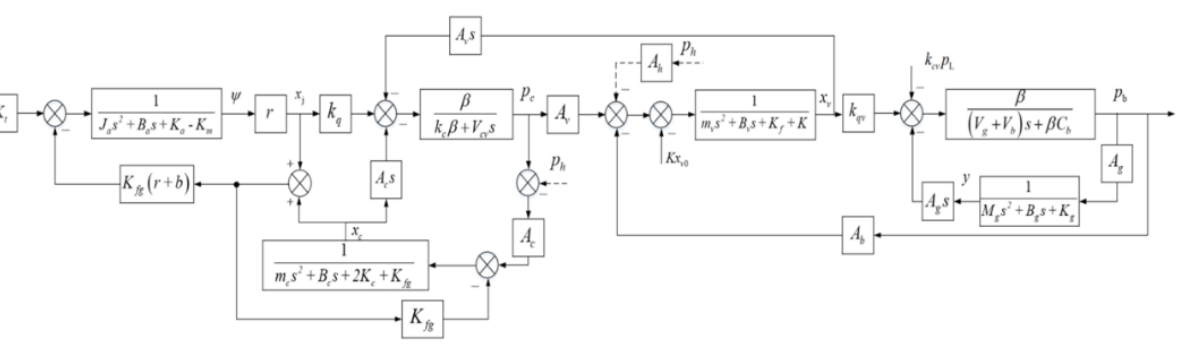
Figure 22. Control block diagram from main valve spool displacement to output pressure. (4) Block diagram of PSVS. According to the control block diagram above, the control block diagram of PSVS (from control current Δ i to output pressure p b ) can be obtained, as shown in Figure 23.